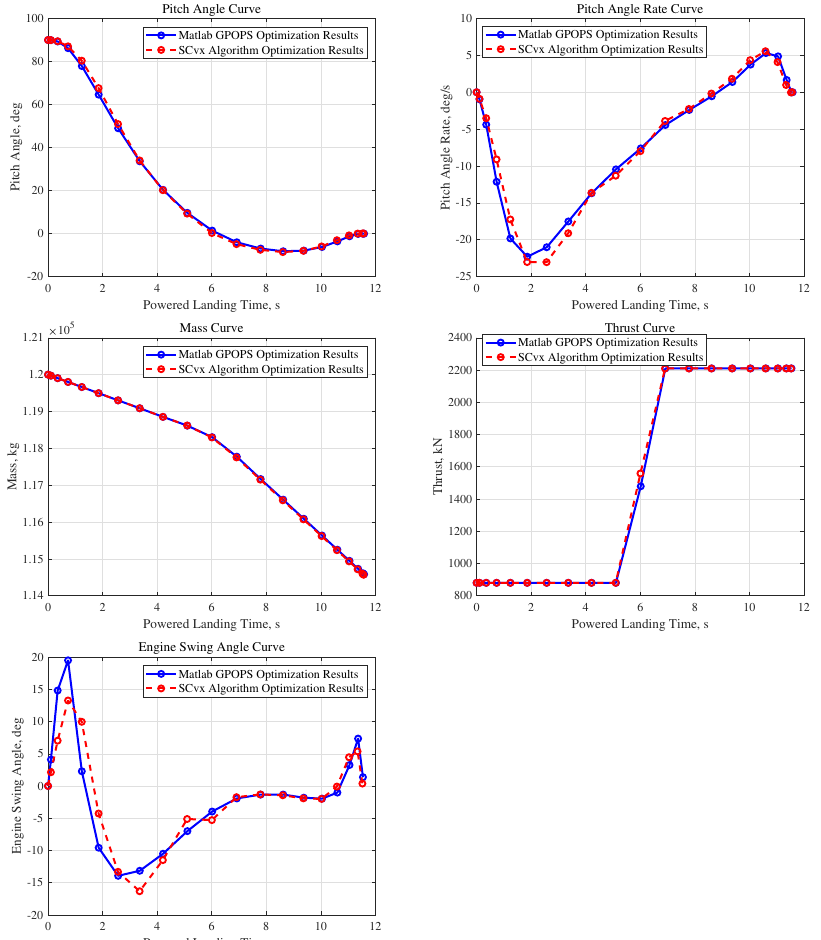
Figure 4. Comparison of optimization trajectories.